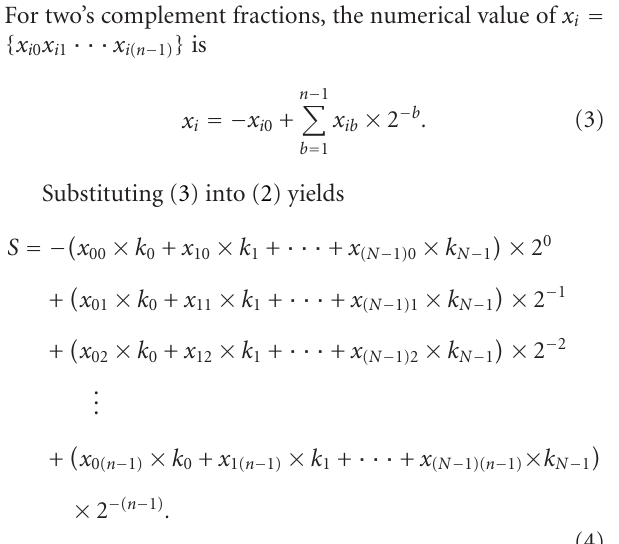
a cascade of lowpass filters with exponentially decreasing cut- o ff frequency from base to